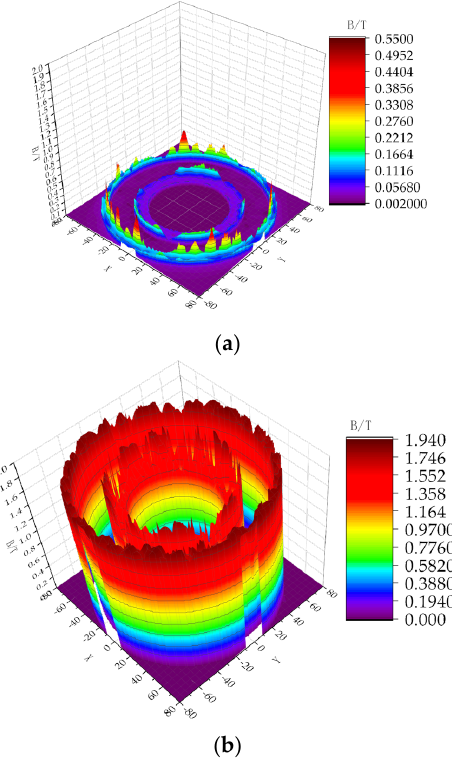
Figure 10. Magnetic flux of contact surface. ( a ) Magnetic flux at 0 s. ( b ) Magnetic flux at 0.6 s.